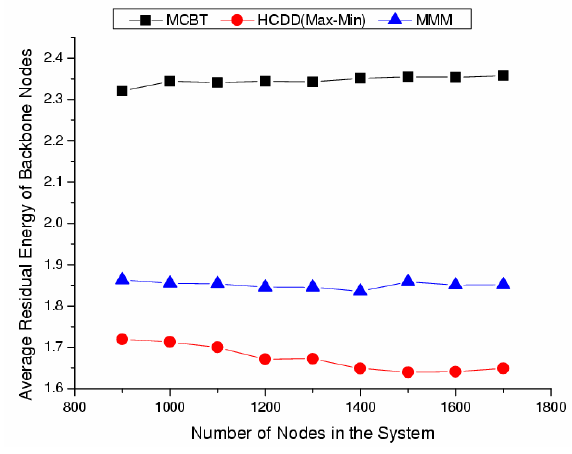
Figure 8. Average residual energy after event occurrence.